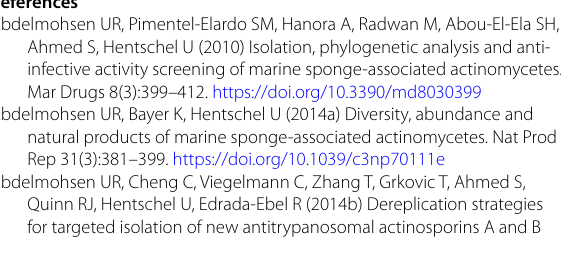
, 600 and 150 MHz) 6